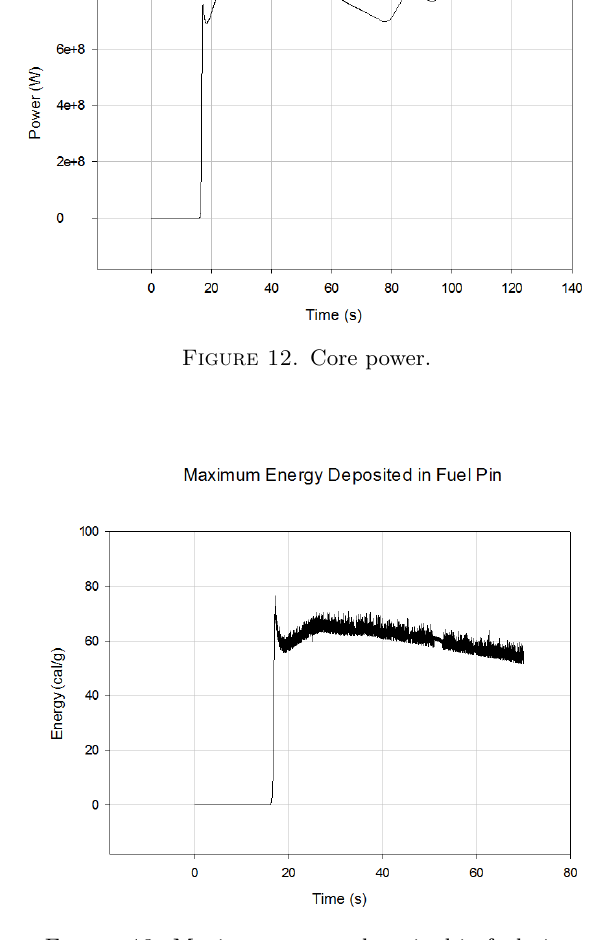
Figure 16. Axial normalized power.